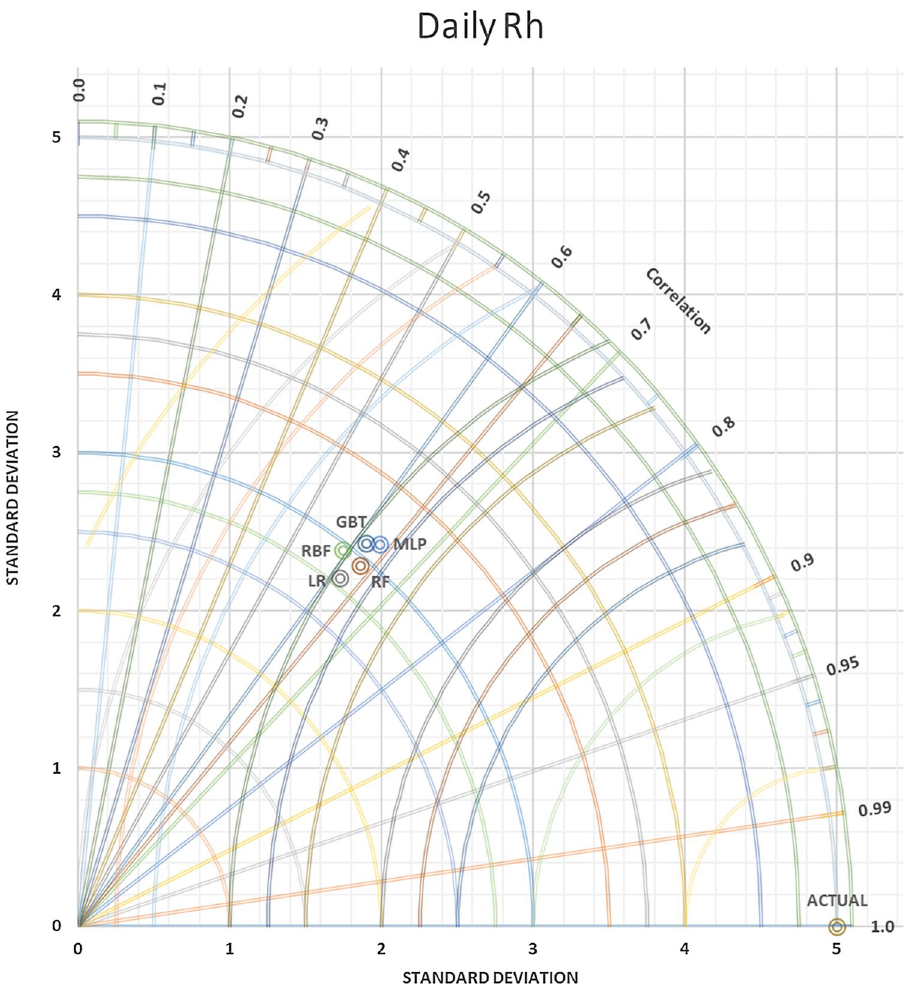
Figure 10. Taylor diagram of predicting daily Rh percent using the most accurate